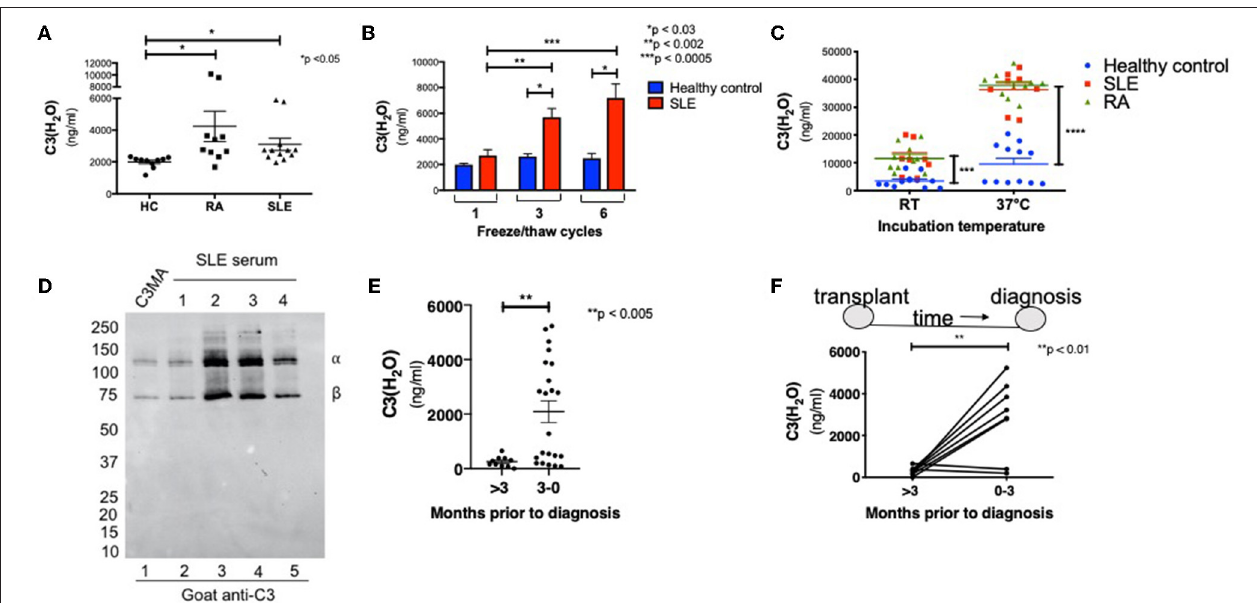
FIGURE 5 | C3(H 2 O) is elevated in complement-mediated conditions. (A) C3(H 2 O) levels were measured in serum samples from RA and SLE patients and compared to serum from healthy donors. All samples had been stored at − 80 ◦ C prior to evaluation; n = 5 (in duplicate; intra-assay precision, %CV 5.59). (B) Serum from SLE patients were subjected to 1, 3, or 6 f/t cycles prior to measuring C3(H 2 O) levels; n = 3. (C) Serum from healthy donors ( n = 6) or patients with SLE ( n = 4) or RA (n = 5) were incubated at RT or 37 ◦ C for 6h before C3(H 2 O) was measured; samples in duplicate. SLE at 22 ◦ C, *** p < 0.0005 vs. healthy control; RA at 22 ◦ C, SLE and RA at 37 ◦ C, **** p < 0.0001 vs. healthy control. (D) Serum from SLE patients ( n = 4) was diluted 1:500 and assessed for C3(H2O) breakdown by WB under reducing conditions with a goat anti-C3 pAb. (E) C3(H 2 O) levels were measured in BAL fluid samples from lung transplant recipients either > 3 months prior to diagnosis ( n = 10) or within 3 months of diagnosis of AMR ( n = 22), ** p < 0.005 by student’s t- test. (F) C3(H 2 O) levels were measured in sequential BAL fluid samples in 8 patients who had paired specimens. Lines connect sequential samples from the same patient; ** p < 0.01 by paired t -test. HC, healthy control; SLE, systemic lupus erythematous; RA, rheumatoid